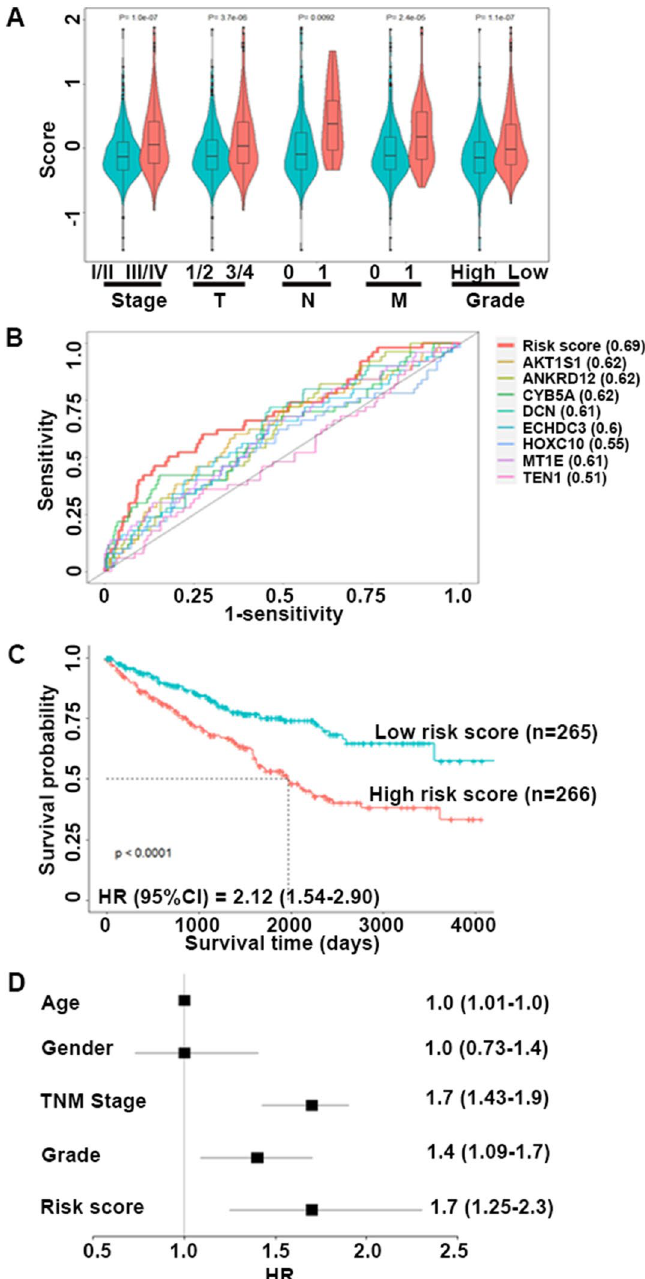
Figure 5. Prognostic Value of Cigarette Smoke Exposure-related Gene Signature in TCGA-KIRC Cohort. ( A ) Violin plots of risk score in the groups of TNM stage (I/II vs. III/IV) (n = 323 and 205 for stageI/II and III/IV); invasion depth (T1/2 vs. T3/4) (n = 341 and 190 for T1/2 and T3/4), lymph node metastasis (N0 vs. N1) (n = 239 and 16 for N0 and N1), and distant metastasis (M0 vs. M1) (n = 422 and 78 for M0 and M1), pathological grade groups (high vs. low) (n = 243 and 280 for high and low); ( B ) Time-dependent ROC curves of individual genes and gene signature for 1-year overall survival; ( C ) Kaplan–Meier curves showed that the overall survival of patients with high or low gene signature defined cutoff (< or ≥ median risk score) in TCGA-KIRC cohort; ( D ) Forest plot of hazard ratios of clinicopathological features and gene signature (risk score) for overall survival of KIRC in multivariate COX regression model. * P < 0.05, ** P <